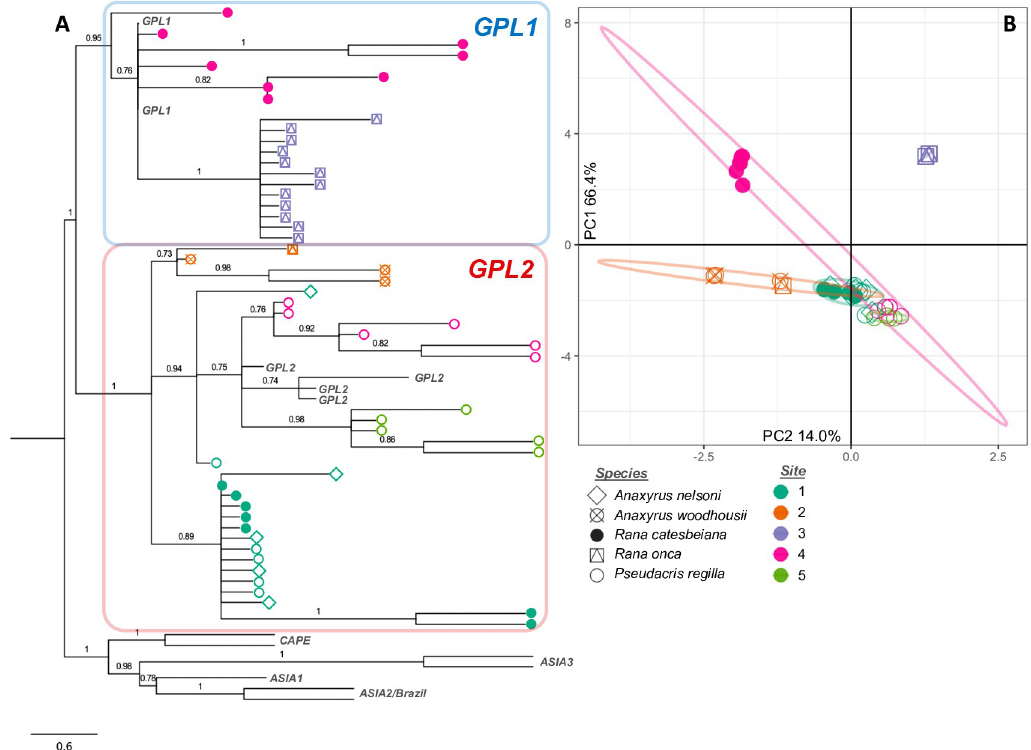
Fig 2. (A) Phylogenetic tree and (B) PCA for 52 Bd samples collected in southern Nevada. Colors represent the locality where the Bd was sampled (numbered as in Fig 1) and symbols represent host species. Tree is calculated using Astral-III and includes and additional 13 reference samples representing all known clades of Bd. Nodes are labeled with posterior probability and those with posterior < 0.7 have been